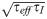
Differential correlation time depends on intrinsic parameters.(a)τs increases (not always monotonically) with τw. For the sake of comparison, we show τs normalized by its small-τw limiting value, τeffτI, vs.τw/τI across τV/τI = 100, 101, 102, 103 104 (from blue to red) with g adjusted so their large-τw limiting value, τV/τeff = 1 + g = 102. Shapes are sigmoidal for τeff/τI > 1 (e.g. green to red) and include an initial dip for τeff/τI < 1 (blue to green). The dot-dashed line denotes τwτI. (b) τs follows the relaxation time, τr, (the dashed line is τs = τr) and saturates at Ω−1. Colors indicate the value of τw/τI on a logarithmic scale from 10−1(red) to 101(purple). (c) General shape of τs vs. ν
0. Values in the blue region are forbidden due the maximum rate achievable in a Gauss neuron. The thick black line denotes the boundary between high and low pass.